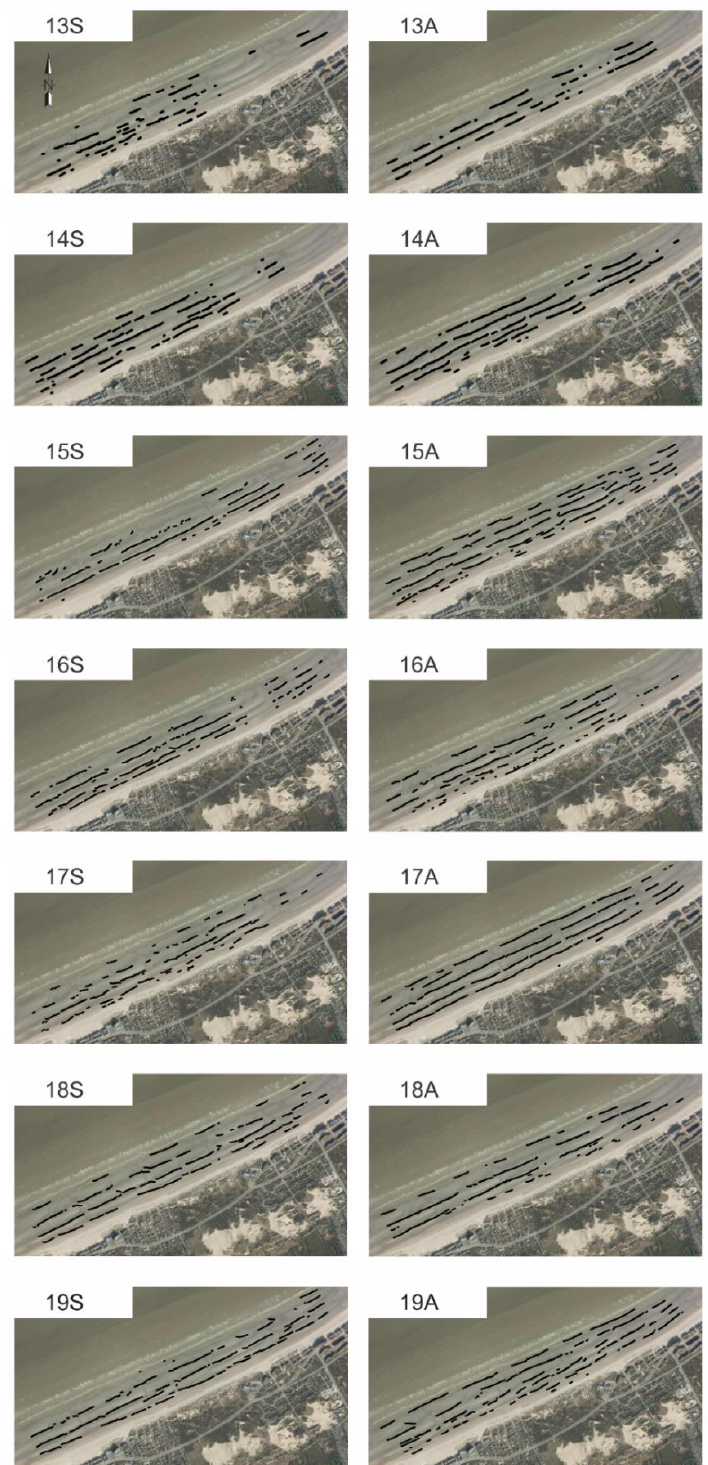
Figure 5. Maps of bar crest positions extracted from the seasonal LiDAR survey dataset from 2013 to 2019. Note: aerial image background is fixed taken in 2015.